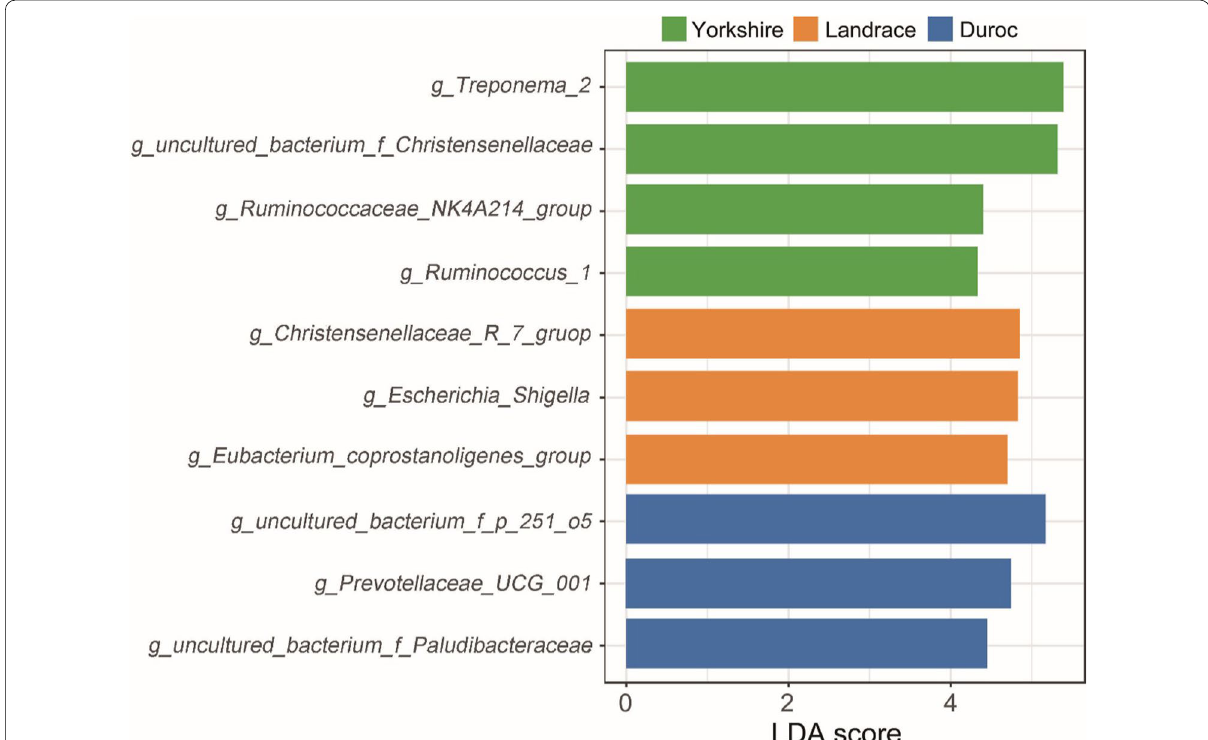
Fig. 2 Biomarkersidentified at the genus level by LEfSe